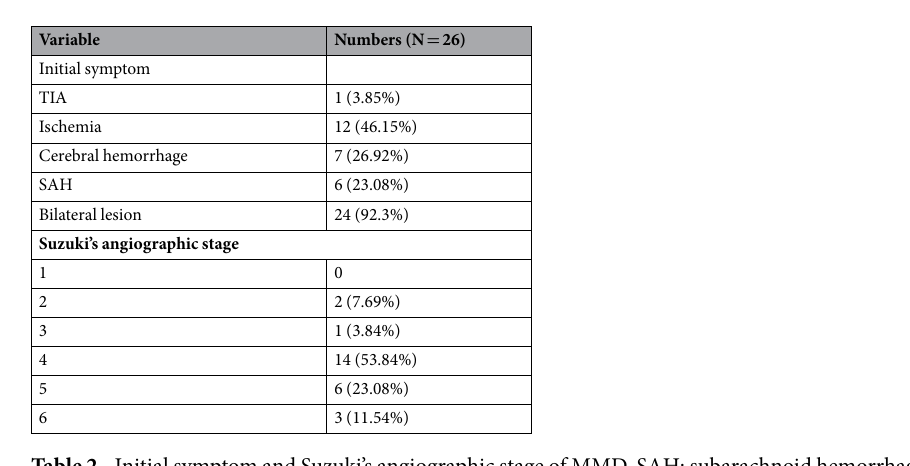
Table 2. Initial symptom and Suzuki’s angiographic stage of MMD. SAH: subarachnoid